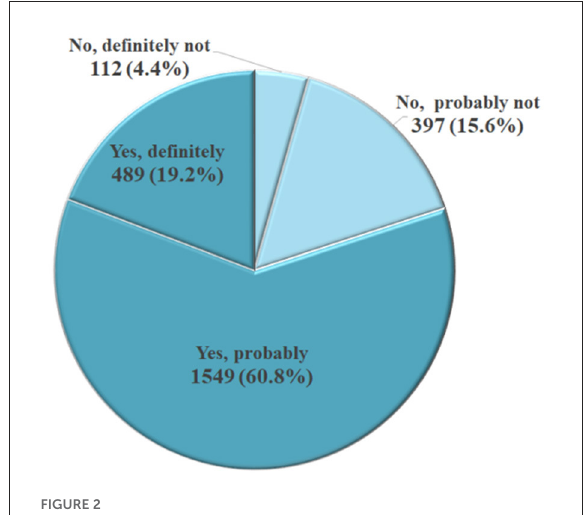
FIGURE2 Intention to take gastric cancer screening in the next 5 years ( N =